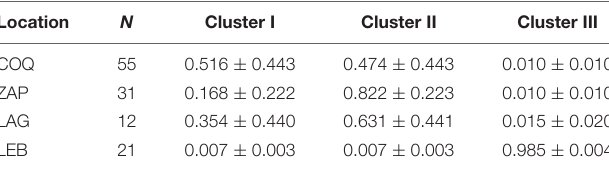
TABLE 5 | Proportion of mean membership ( Q ± SD) of G. chilensis individuals from each locality to each of the three genetic groups inferred by STRUCTURE. Location